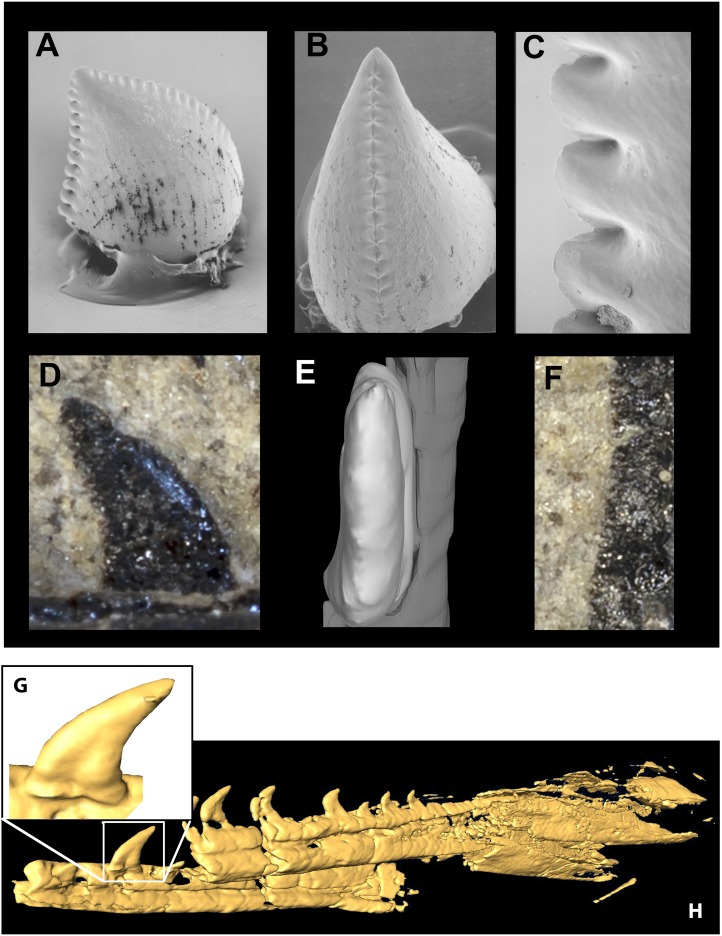
Mandible and comparative tooth morphology of Koparion and Hesperornithoides.Tooth of Koparion in “side” (A) and mesial (B) views, and a detail of the distal serrations (C). Hesperornithoides maxillary tooth in labial view (D), rendered from CT data in mesial view (E) and a detail of the distal serrations (F). Segmented CT data of fully erupted tooth (G) and anterior mandibular elements of Hesperornithoides in oblique view (H). Photo credit (A–C): Dan Chure.